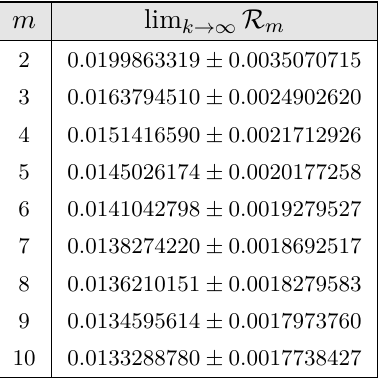
Figure 21. Variation of Rényi entropies for the state | 6 2 # T 2 , 2 i with k